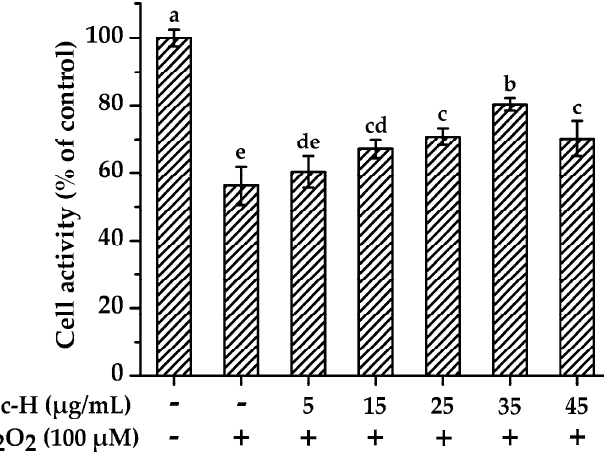
Figure 3. Protective effects of alcalase hydrolysate (Alc-H) on hydrogen peroxide (H 2 O 2 )-induced cytotoxicity. PC12 cells were pretreated with various concentrations of Alc-H (5–45 μ g/mL) for 12 h before being exposed to 100 μ M H 2 O 2 for 1 h. Cell viability was determined using the CCK8 assay. Data are expressed as mean ± SD ( n = 4). Bars with different alphabets indicate statistically significant difference between the means ( p < 0.05).